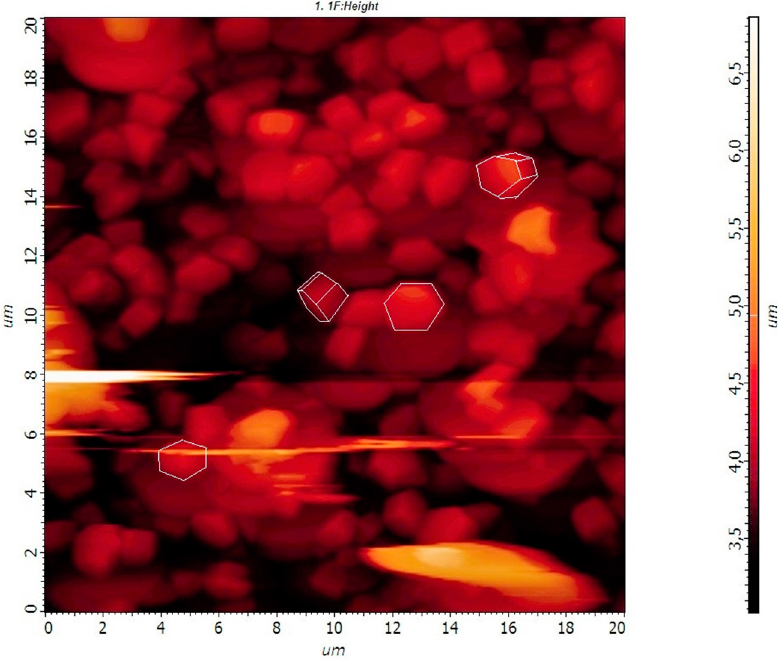
Figure 3. AFM image of the sample β -NaYF 4 : 20%Yb, 1% Tm, 5% Gd.